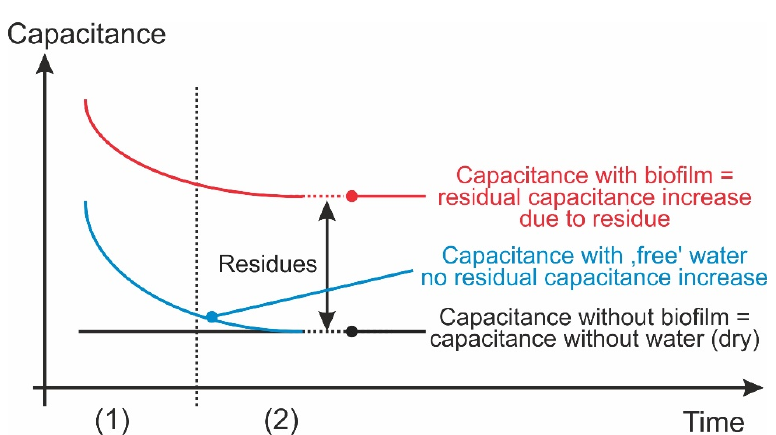
Figure 1. Functional principle of the process, showing the theoretical (idealized) time courses of capacitance due to heating, which are not affected by the actual temperatures. The procedure consists of (1) a (standardized) heating phase, in which water on the surface of the structure not bound to the biofilm matrix evaporates completely, while matrix-bound water remains predominantly (or at least partially) on the surface, and (2) a cooling phase, in which undisturbed ambient conditions are re-established. During both phases, the electrical capacitance of the sensor structure is measured.